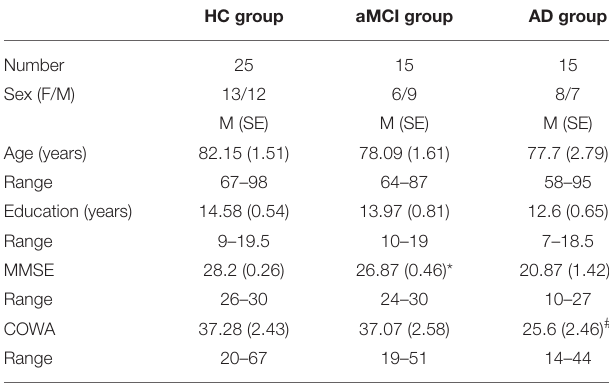
TABLE 1 | Demographic characteristics of the study